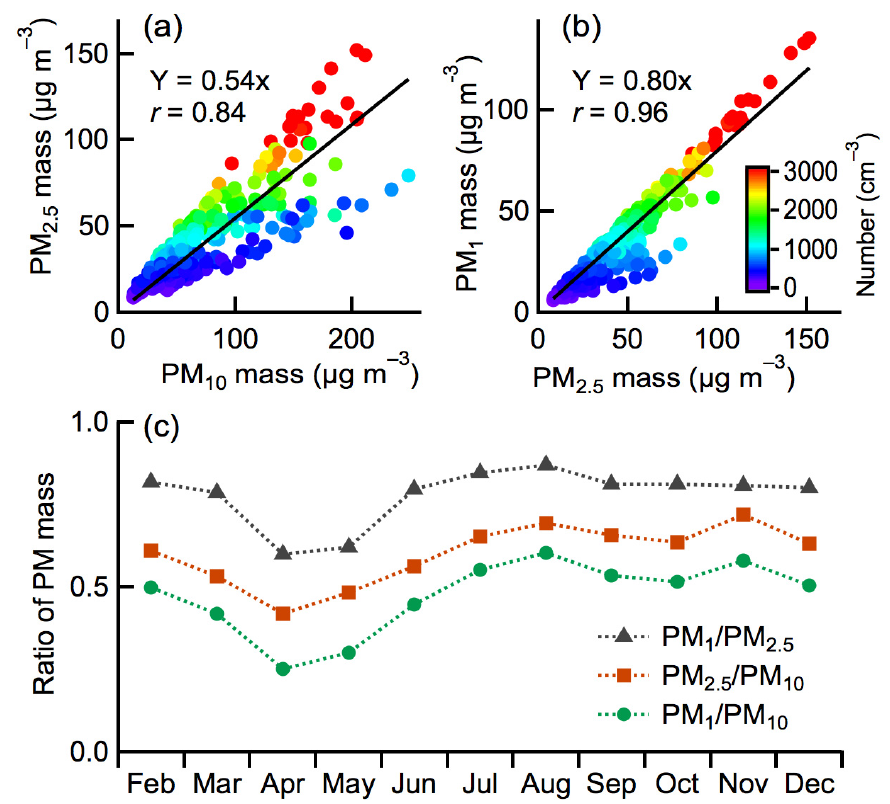
Figure 2. Correlations of the mass concentration of ( a ) PM 2.5 vs. PM 10 and ( b ) PM 1 vs. PM 2.5 over the studied period, and ( c ) the monthly averages of the mass concentration ratios of PM 1 /PM 2.5 , PM 2.5 /PM 10 , and PM 1 /PM 10 .